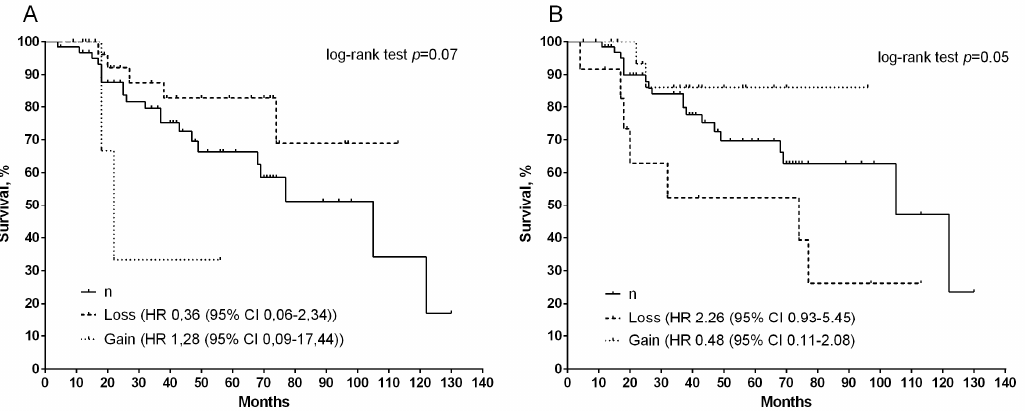
Figure 3. Curves of metastatic survival of patients with breast cancer, depending on CNA gene RRM1 ( A ) and GSTP1 ( B ), (log-rank test p = 0.07 and p = 0.05). Table 4. Multivariate Cox regression analysis for metastasis-free survival of patients with breast cancer.